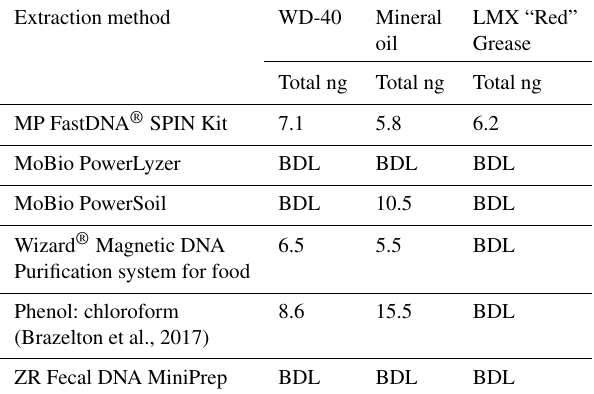
Table 1. Comparison of DNA-extraction methods with three test samples. Six DNA-extraction methods were compared on three test samples (WD-40, mineral oil, and LMX “Red” grease), chosen for their similar properties to industrial grade lubricants. The test sam- ples were spiked with E. coli cells. All DNA yields from un-spiked test samples were below the detection limit (BDL). Each column shows the total amount of DNA extracted